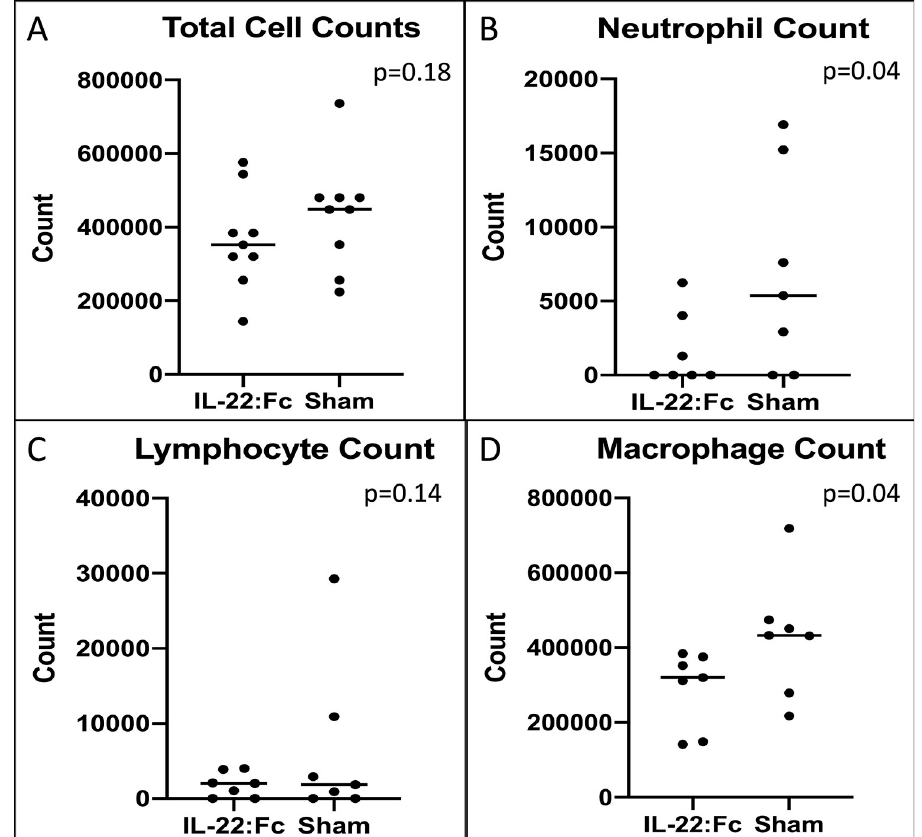
Fig 1. Cellular influx after low-dose LPS lung injury. Mice with low-dose LPS injury have decreased cellular influx of B) neutrophils and D) macrophages into the lungs when treated with IL-22:Fc as shown in BAL cell counts. There was no difference seen in A) total cell counts and C) lymphocyte